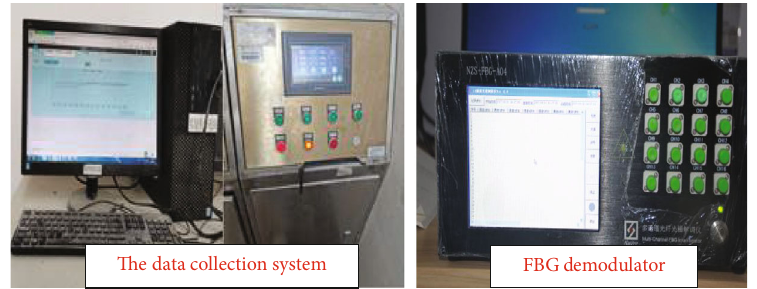
Figure 7: The intelligent data collection system [43].